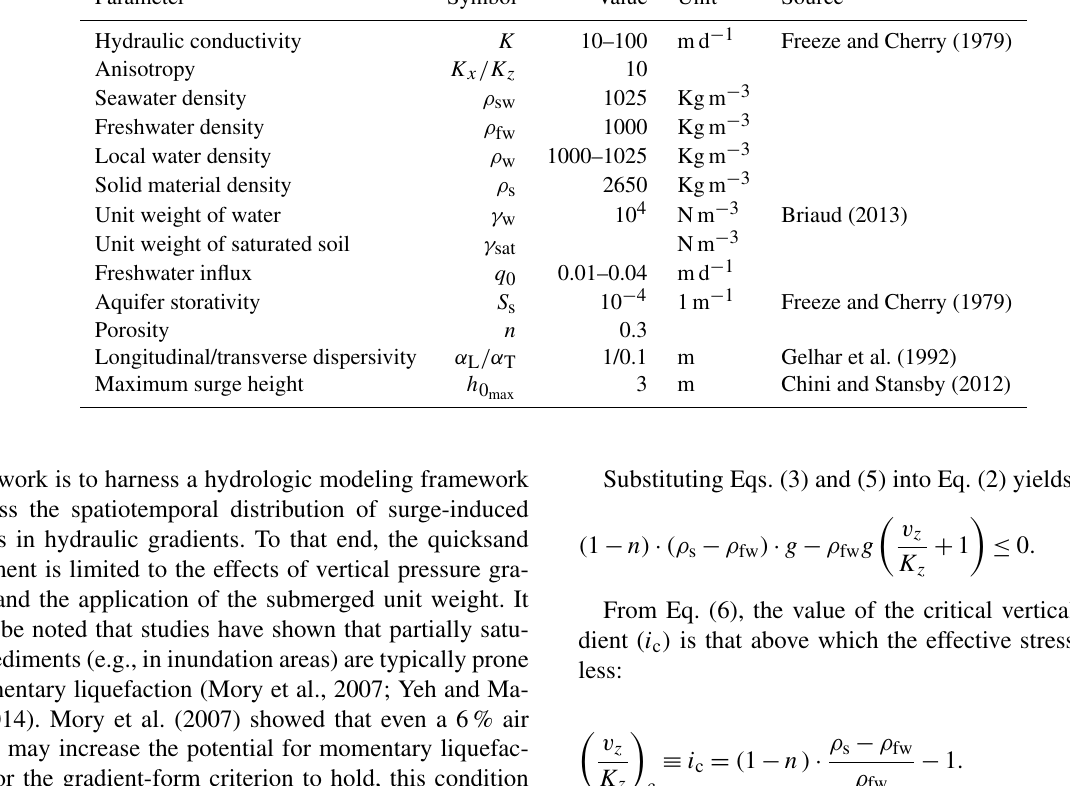
Table 1. Variables used in the theoretical calculations and numerical simulations.